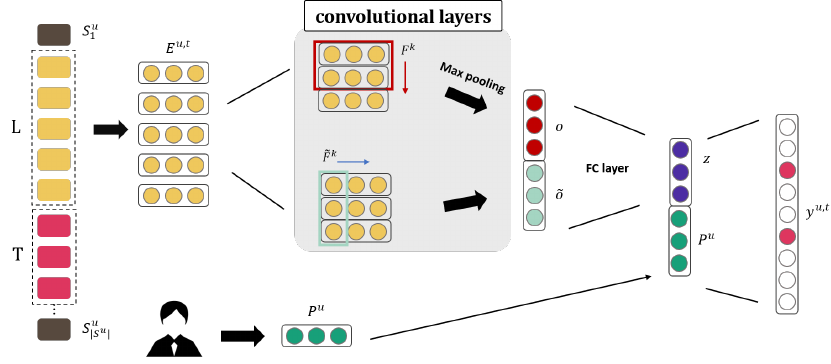
Figure 3. Model architecture of Caser